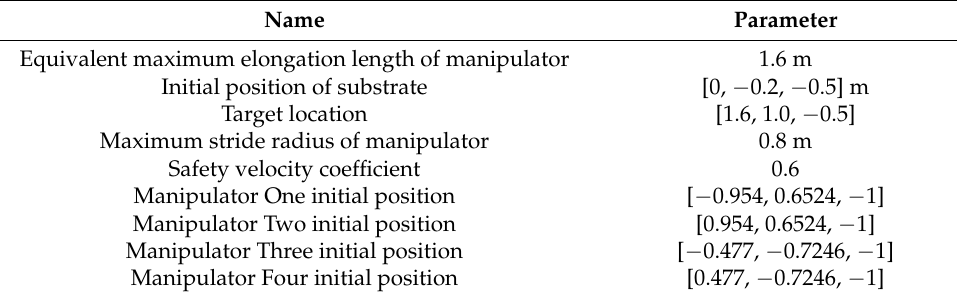
Table 2. Space robot motion performance equivalents.